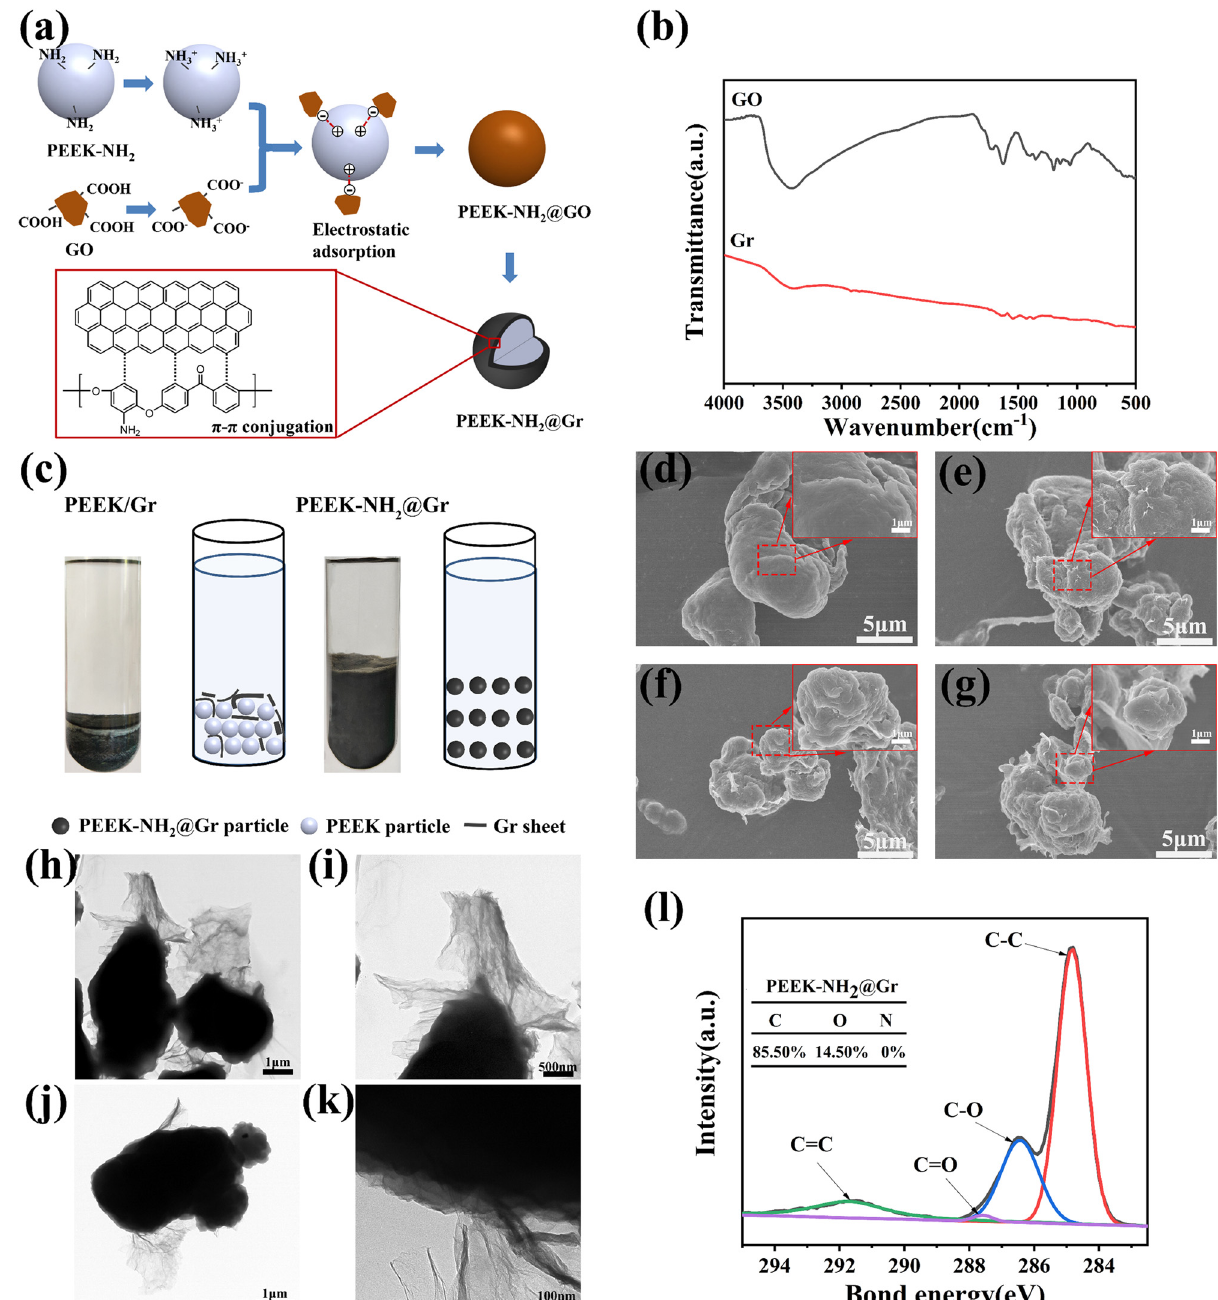
Figure 3: ( a ) Schematic illustration of electrostatic adsorption between PEEK - NH 2 and Gr, ( b ) FTIR spectra of GO and Gr, ( c ) digital photographs of same content PEEK/Gr and PEEK - NH 2 @Gr in solution and schematic illustration of volume state, ( d ) SEM images of PEEK - NH 2 , ( e ) PEEK - NH 2 @0.5 wt% Gr, ( f ) PEEK - NH 2 @1 wt% Gr, ( g ) PEEK - NH 2 @3 wt% Gr, ( h – k ) TEM images of PEEK - NH 2 @2 wt% Gr, and ( l ) C 1s peek - fi tting curve of PEEK - NH 2 @2